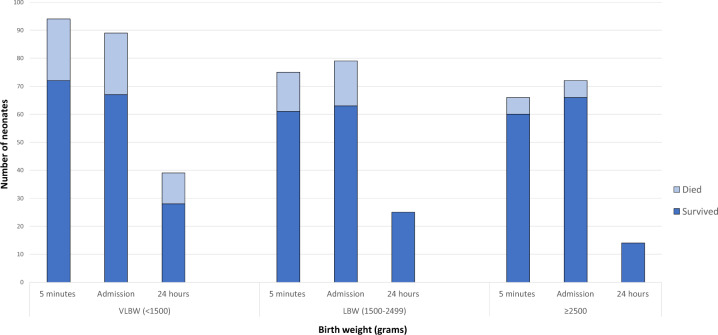
Frequency of hypothermia at 5 min, on admission to NICU, and at 24 h, by birth weight, stratified by those that died vs. survived. LBW, low-birth weight; VLBW, very low-birth weight.